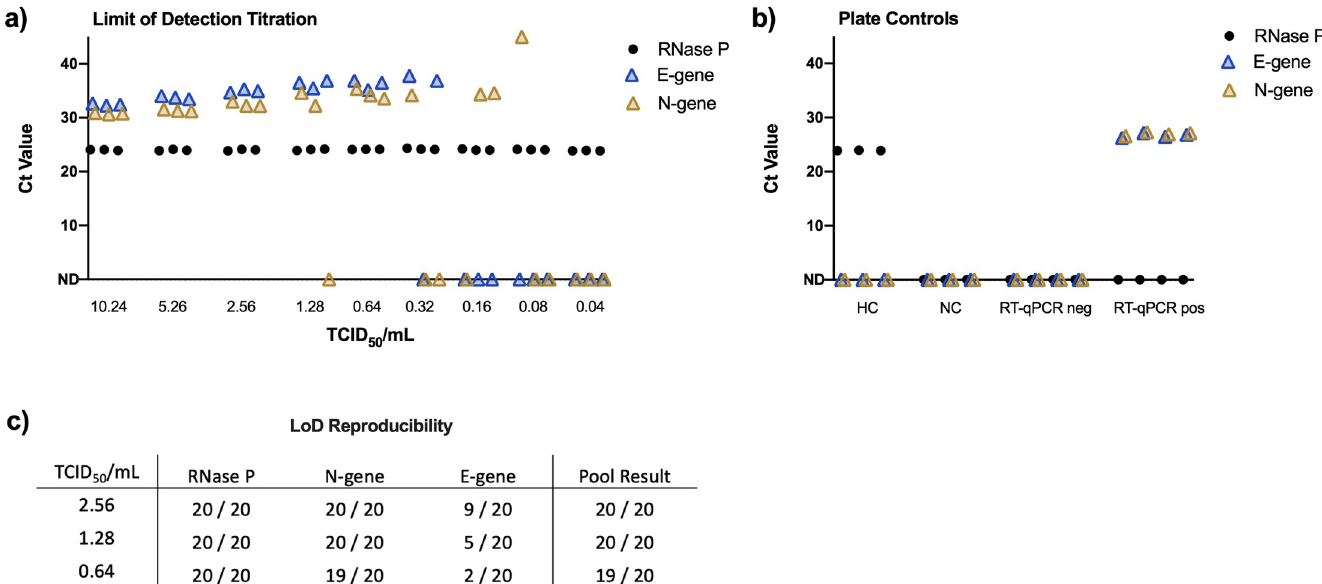
Fig 3. Limit of detection and reproducibility. a) The limit of detection was defined by extracting RNA from heat-inactivated virus at concentrations ranging from 10.24 to 0.01 TCID 50 /mL and performing RT-qPCR with the LuNER reagents. b) Representative plate controls for the LuNER assay are shown from the LoD titration experiment, including negative buffer-only control (NC), human RNA control (HC), RT-qPCR negative (blank), and RT-qPCR positive controls (synthetic SARS-CoV-2 RNA genome). c) An independent experiment showing reproducibility of the LoD at 0.64, 1.28, and 2.56 TCID 50 /mL.